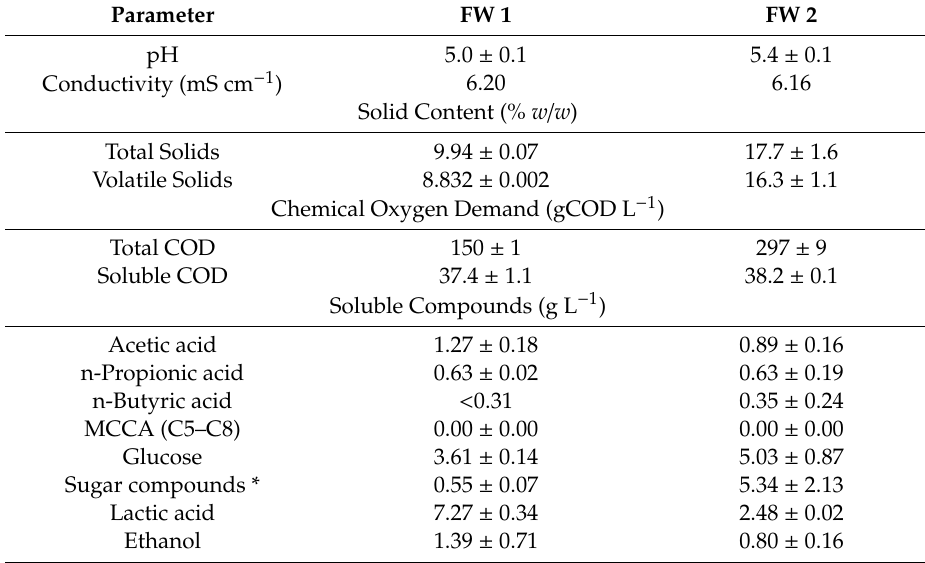
Table 1. Characteristics of the two food waste substrates (FW 1 and FW 2) used in this study. Analysis was performed in duplicate and presented with standard